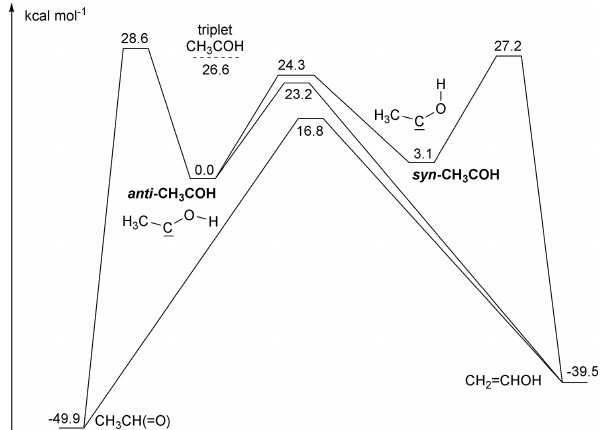
Figure 3. Zero point energy (ZPE)-corrected potential energy surface for unimolecular reactions of singlet CH 3 COH at the CCSD(T)//M06-2X-D3 level of theory.